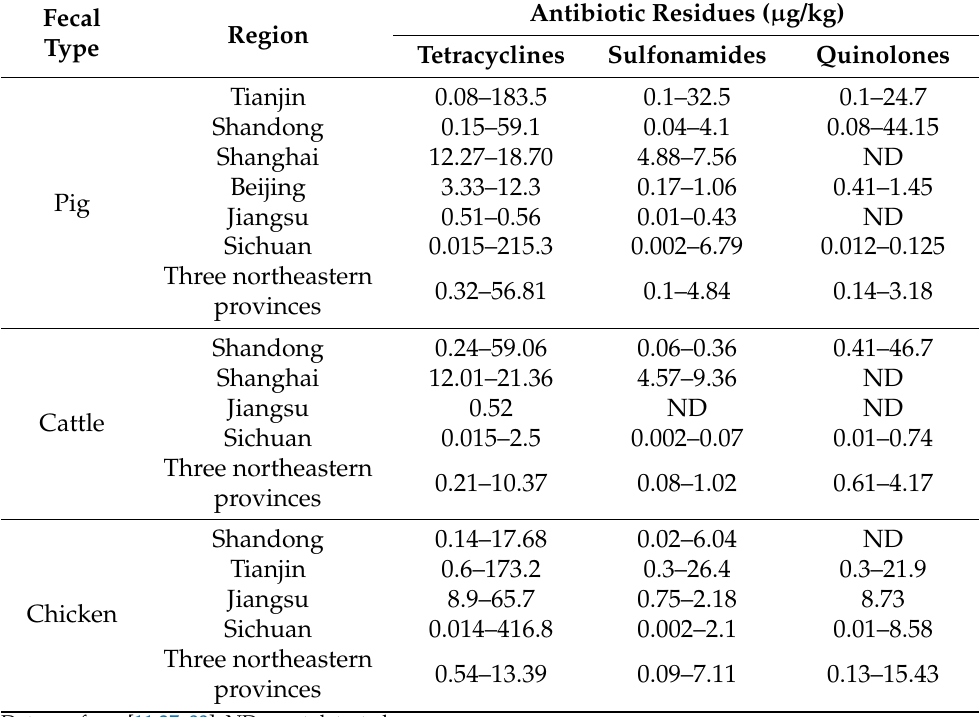
Table 1. According to the data, tetracyclines (TCS), sulfonamides (SAS), and quinolones (QNS) were commonly residual in livestock manure, and the concentration of tetracycline antibiotics was high. Table 1. Residues of antibiotics in animal